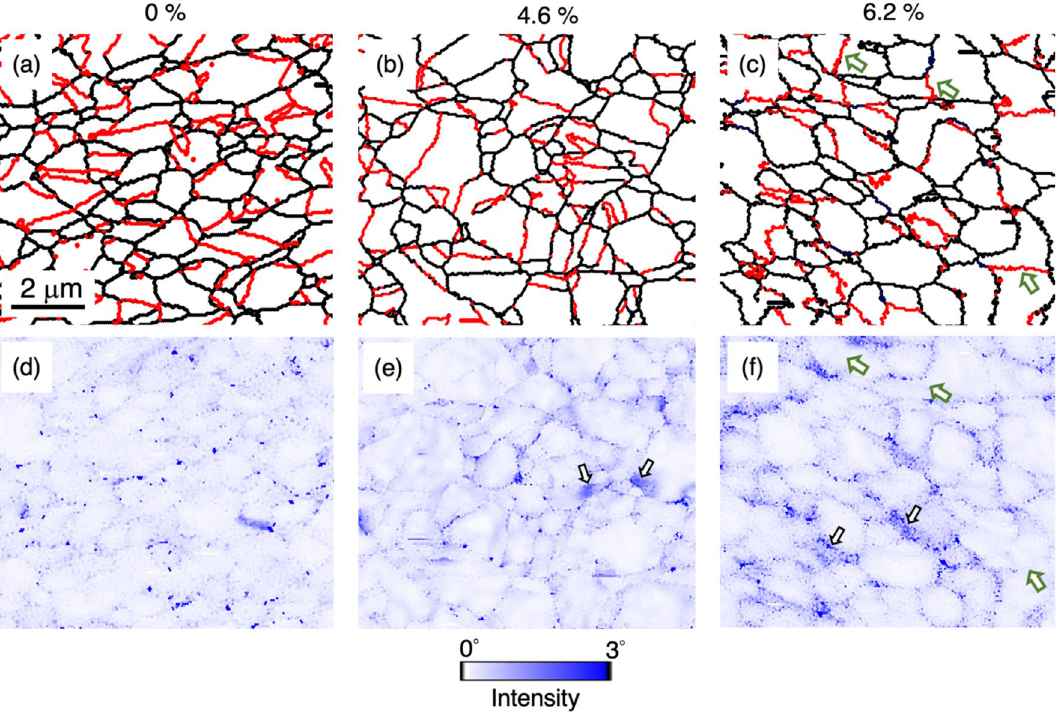
Figure 1. EBSD maps of undeformed (0%) and two tensile strained (4.6% and 6.2%) UFG samples with the scan step size of 50 nm: ( a – c ) grain boundary maps, ( d – f ) kernel average misorientation maps of (a-c). Black lines in ( a – c ) represent the high angle boundaries with rotation angle (θ), 15° ≤ θ < 60°, and red lines represent Σ3{111} twin boundaries. The average misorientation showing in ( d–f ) was calculated by taking the points as well as all of its nearest neighbors into account with a criterion that the misorientation exceeding the threshold (3°) was discarded from the calculation. The stress concentration and several representative Σ3{111} twin boundaries are indicated by white arrows and green arrows, Fig. 2c–e, three twin lamellas having different sizes ranging from 100 to 500 nm were observed. The narrow twin width, i.e., nanometer grain size, made the activation of in-grain dislocations difficult, meanwhile deformation twin nucleation at Σ3{111} twin boundaries was evident. Strain contrast that uniformly spread along the Σ3{111} twin boundaries was observed regardless of the width of twin lamellar. This characteristic localized strain con- trast within the Σ3{111} twin boundaries as well as deformation twins observed near/at twin boundaries shown in the three TEM images were not identified by the EBSD analysis possibly because of the limitation of EBSD’s spatial resolution, i.e., the size of deformation twins (~ 3 nm) and the extremely localized strain within Σ3{111} twin boundary are too small to be identified. Figure 3a–d are selected frames extracted from an in-situ TEM tensile deformation test movie (full video provided in Supplementary Information). Several stacking faults were nucleated on both sides of an annealing twin grain, i.e., the two Σ3{111} twin boundaries. In addition, a few dislocations were observed in the upper left corner. These are indicated by the arrows filled with dots and the black arrow in the figures, respectively. It is worth noting that the stacking faults were inclined relative to the incident electron beam in this imaging condition thus they look wider. In the initial stage of plastic deformation, the nucleation of stacking faults from both sides of an annealing twin grain, as well as a few dislocations gliding took place simultaneously as seen in Fig. 3a and b. The observed stacking faults emission from the Σ3{111} twin boundary without having notice- able in-grain dislocation − Σ3{111} twin boundary interaction suggests that no localized stress concentration field was generated by the dislocation pile-up for twin nucleation. The contrast of the stacking fault on the left hand side of Σ3{111} twin boundary was vanished in Fig. 3c, which could be ascribed by the emission of the trailing partial dislocation or the third overlapping stacking fault that made the contrast of the stacking fault nearly invisible, i.e., phase angle α becomes 2π as equivalent as the perfect lattice 32 . The leading Shockley par- tial dislocations were continuously emitted from the Σ3{111} twin boundary (Fig. 3d) as the in-grain slip was significantly suppressed and the stacking fault became visible again. The outer fringe contrast of the fault 2 (F 2 ) turned from dark to bright, i.e., two stacking faults (F 1 and F 2 ) were overlapping and showed the reversal fringe contrast. These spontaneously successive emission events occur rapidly at the Σ3{111} twin boundary and is found to be characteristically different from the one induced by in-grain dislocations− Σ3{111} twin boundary interaction in the CG counterpart in Supplementary Fig. S1 26 . A Thompson tetrahedron inserted in Fig. 3d provides the crystallographic relationship between the Σ3{111} twin boundary and the emitted stacking fault. In the deformation process, Shockley partial dislocations having the Burgers vector of b 1 and b 2 will glide on